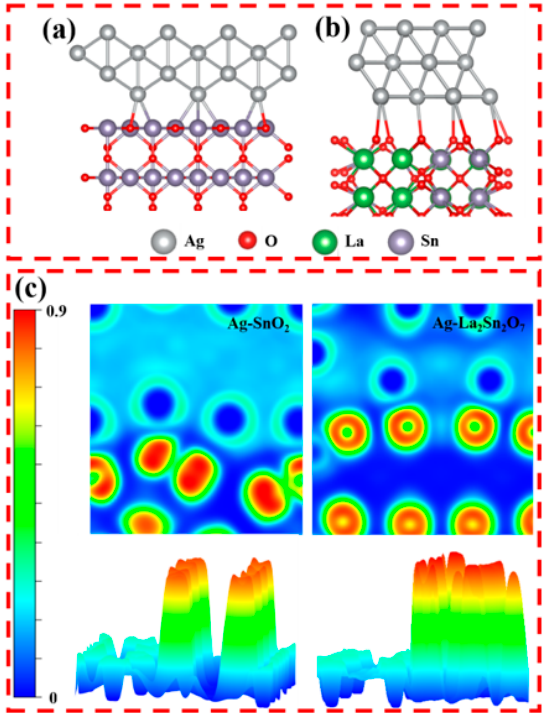
Figure 1. Established models of the ( a ) Ag-SnO 2 and ( b ) Ag-La 2 Sn 2 O 7 interfaces; ( c ) electronic localization function (ELF) for the Ag-SnO 2 and Ag-La 2 Sn 2 O 7 interfaces.